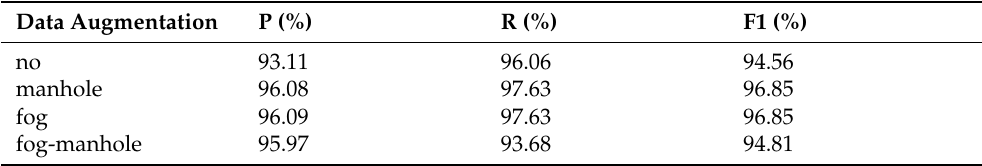
Table 6. Based on YOLOv5s model, compare the results of data augmentation in the pothole600